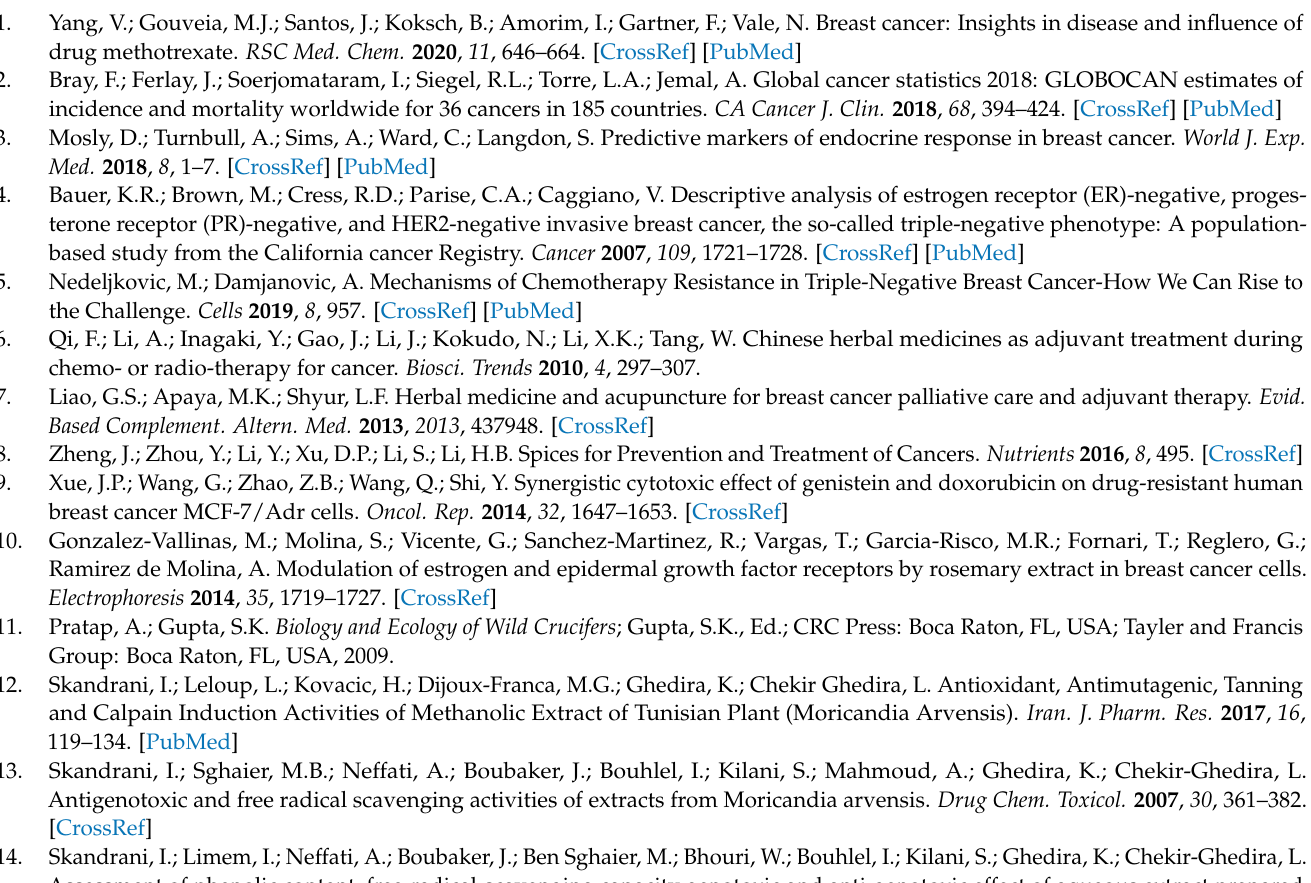
Table S2: Swiss protein target prediction report for compound 1,2-benzenedicarboxylic. Table S3: Swiss protein target prediction report for compound “hexadecanoic